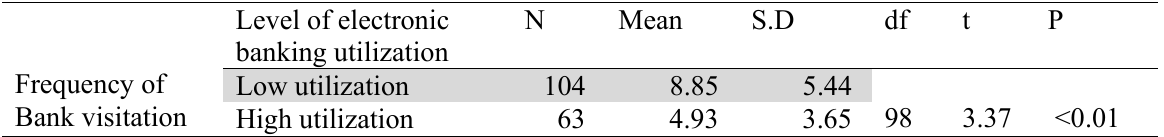
t-test summary table showing the influence of electronic banking utilisation on Frequency of bank visitation Level of electronic N banking utilization Frequency of Bank visitation